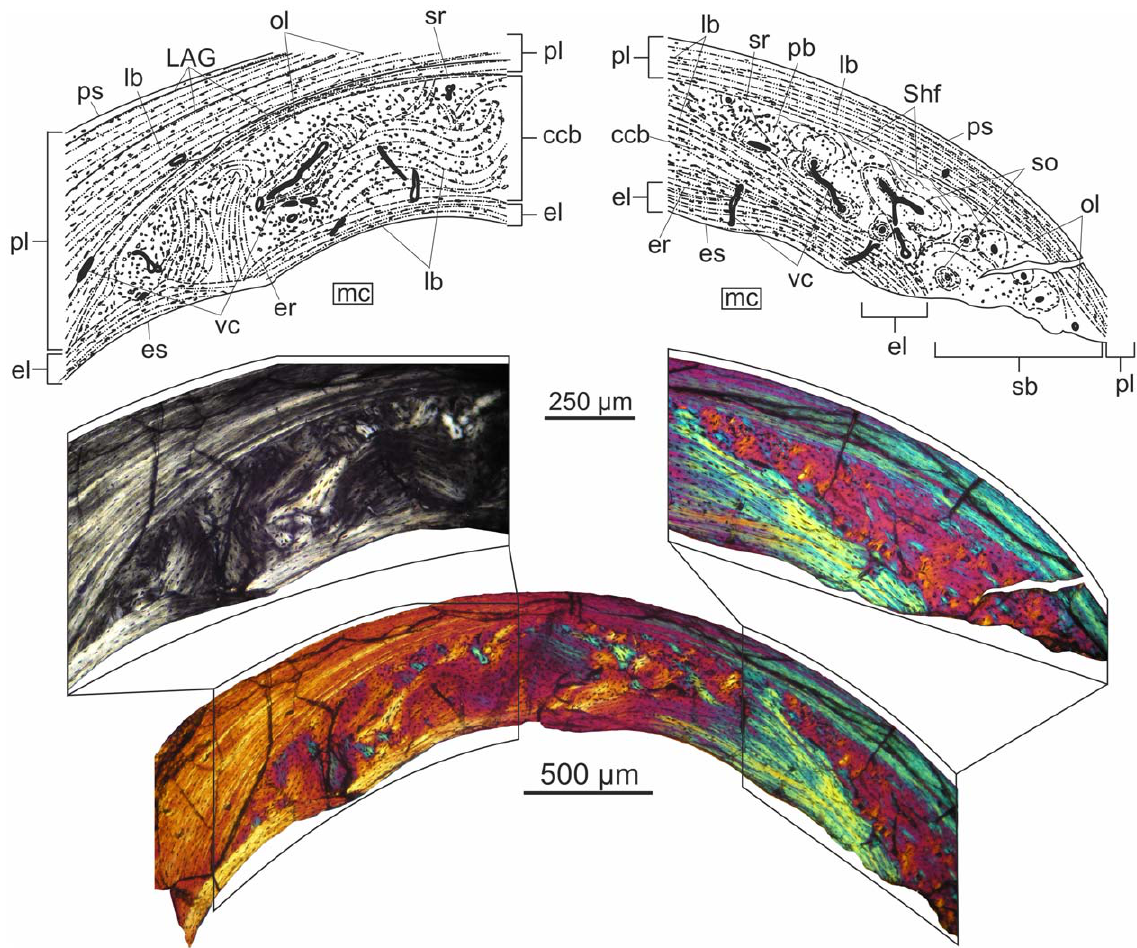
Figure 3. Ulnar histology of MTM 2008.33.1. under crossed polarizers. Peripheral to the thick endosteal layer, extensive compacted coarse cancellous bone forms the middle layer of the cortex. Locally, the middle cortical layer consists of loose Haversian bone. The outer periosteal layer is composed of a strongly asymmetrical OCL.